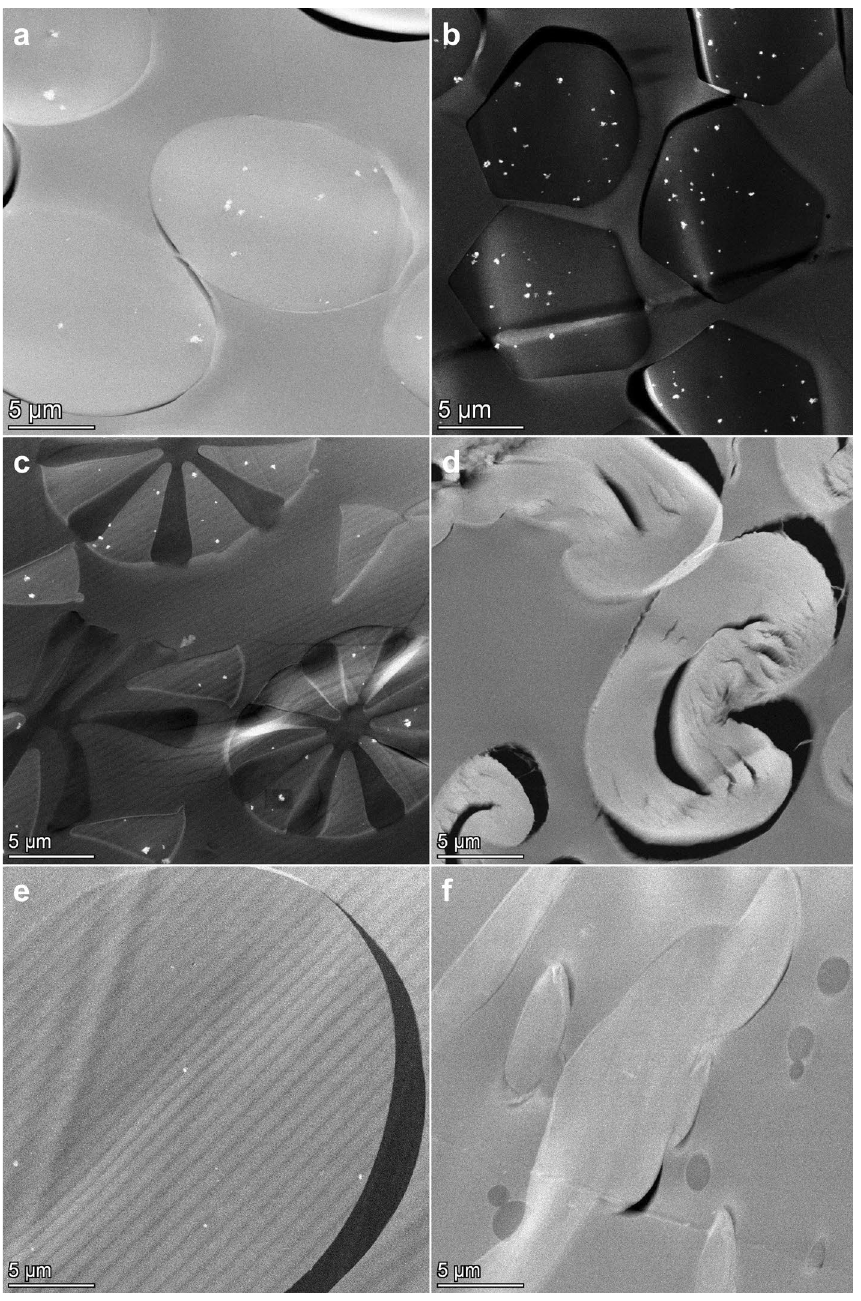
Figure 1. HAADF- STEM images of sections of different types of fibers observed in the face masks, with ( a ) polyester, ( b ) polyamide, ( c ) bi-component microfiber, ( d ) cotton, ( e ) thermobonded non-woven fiber, ( f ) meltblown non-woven fabric. TiO 2 particles are visible as bright white